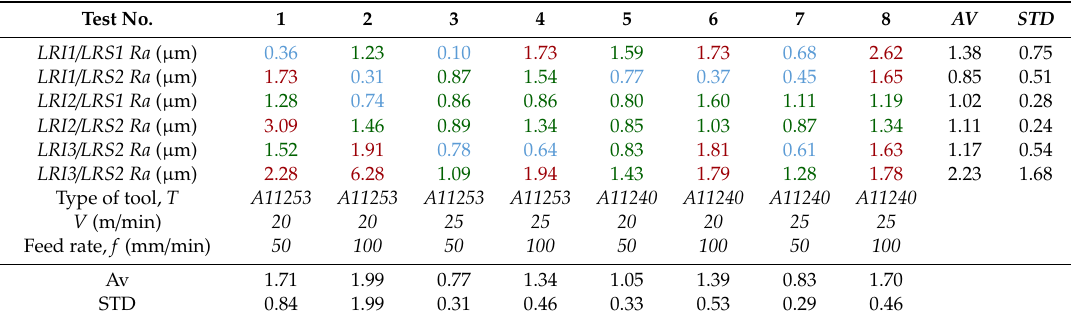
Table 9. Mg-Ti-Mg test. Arithmetical Mean Roughness, Ra ( µ m), measured in each plate at the entry and at the exit zones of the holes. Adapted from